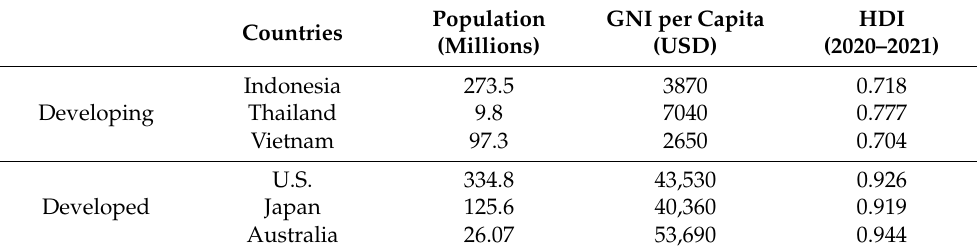
Table 1. HR development in major Southeast Asian